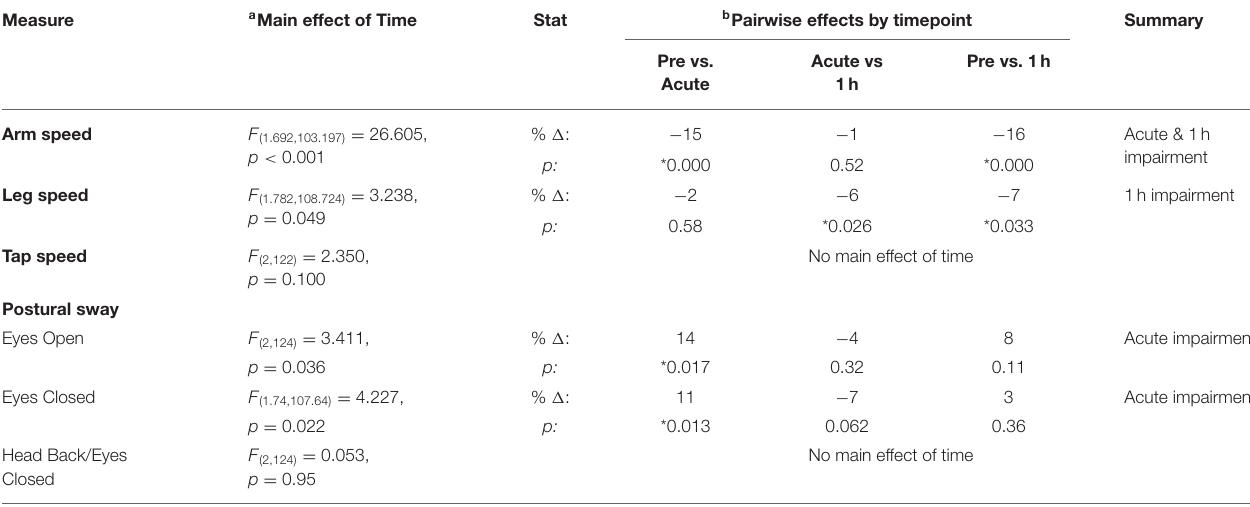
TABLE 2 | Effects of concentrate use over time on motor performance.